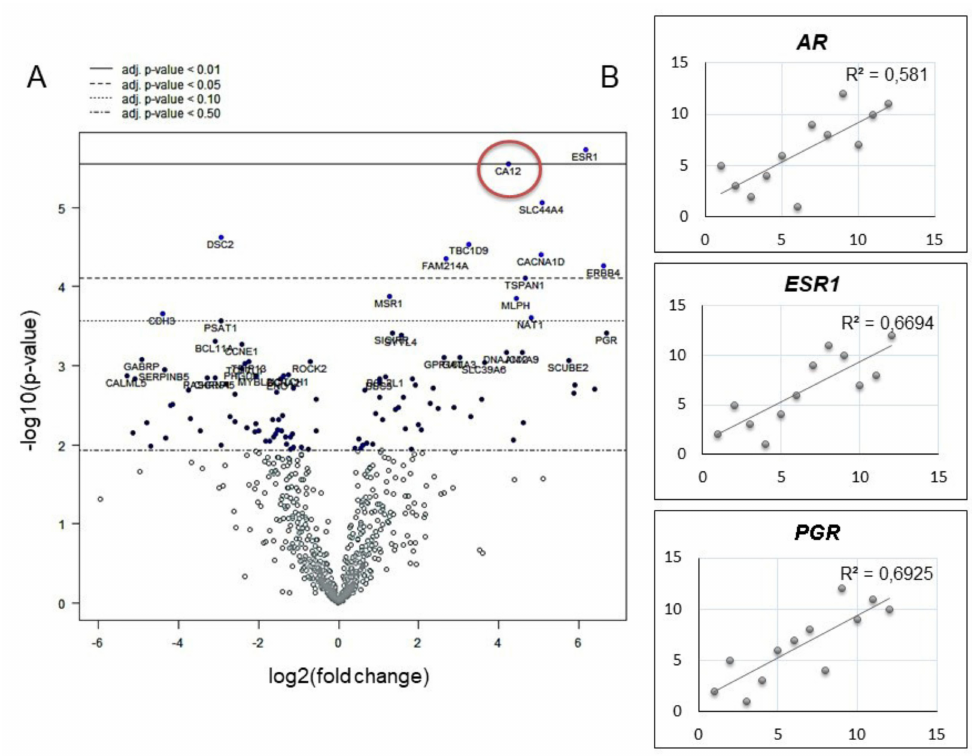
Figure 2. mRNA analysis of CA12 expression in breast cancer tumors. ( A ) Di ff erential expression between luminal A and triple negative patients analyzed on NanoString data: fold change of 4.23 (95%CI: 3.51–4.95, p = 0.0066). ( B ) Correlation of transcripts per million (TPM) counts analyzed by RNA-seq between CA12 and hormone receptor genes: CA12 showed a positive correlation with androgen receptor ( AR ), estrogen receptor ( ESR1 ), and progesterone receptor ( PGR ) with a Spearman correlation coe ffi cient of 0.766, 0.818, and 0.832, respectively. All coe ffi cients were statistically significant ( p = 0.0020; p = 0.00057; p =